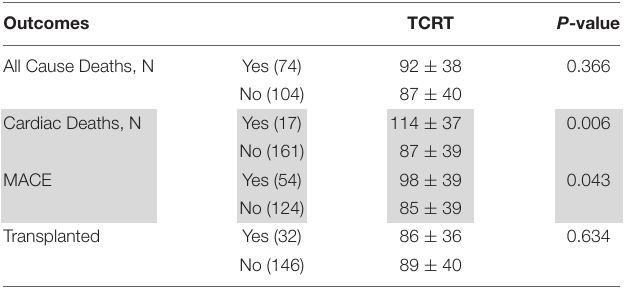
TABLE 2 | TCRT according to end points and to transplant status during follow up.